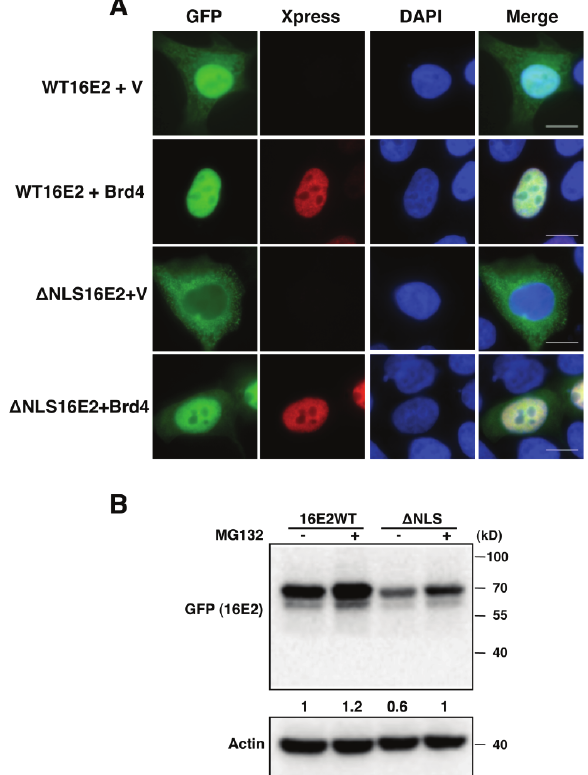
Figure 2. Full-length Brd4 recruits HPV16 E2 and a HPV16 E2 nuclear localization mutant to the nucleus and prevents their degradation by the proteasome. ( A ) HEK293T cells were transfected with either an empty pcDNA4C vector (V) or pcDNA4C-hBrd4 and a GFP construct encoding wild type HPV16 E2 (WT16E2) or Δ NLS-HPV16 E2 mutant ( Δ NLS16E2). Transfected cells were stained with Xpress antibody (red) for Brd4 and counterstained with DAPI. Bar, 5 μ M; ( B ) HEK293T cells were transfected with either pEGFP-C1-HPV16 E2 (16E2WT) or pEGFP-C1- Δ NLS16 E2 ( Δ NLS). Forty-four hours post-transfection, the cells were treated with either 30 μ M MG132 or DMSO for 4 h, and lysed as described in Materials and Methods. A portion (30 μ g) of total cell lysates was resolved on a SDS-PAGE gel and immunoblotted with antibodies recognizing GFP (for HPV16 E2s) and actin. This experiment was repeated three times with similar results. Protein bands from the immunoblots were quantitated with Image J software, using the actin signal for normalization. Signal intensities were then normalized to 16E2WT treated with dimethyl sulfoxide (DMSO) (lane